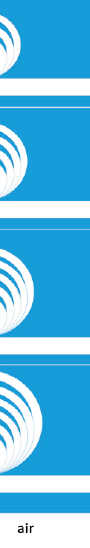
Figure 4. Multiring resonator structure. ( a ) Three rings; ( b ) four rings; ( c ) five rings and ( d ) six rings.